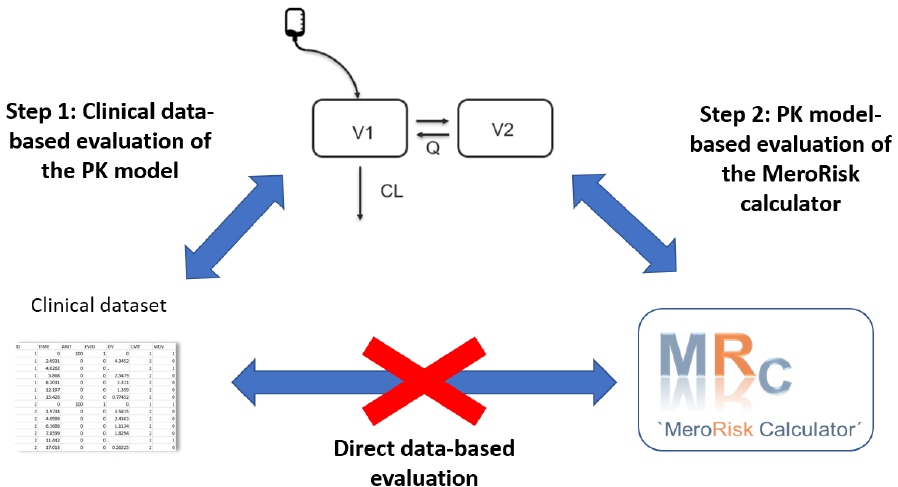
Figure 5. Stepwise evaluation strategy of the MeroRisk-Calculator using a clinical routine dataset. A direct, data-based evaluation of the MeroRisk-Calculator was not feasible due to the time varia- ble sampling time points under routine conditions. A population pharmacokinetic (PK) model was evaluated for its potential to predict the concentrations observed at variable time points (Step 1) and the risk predictions by the PK model were used as a benchmark for the risk predictions of